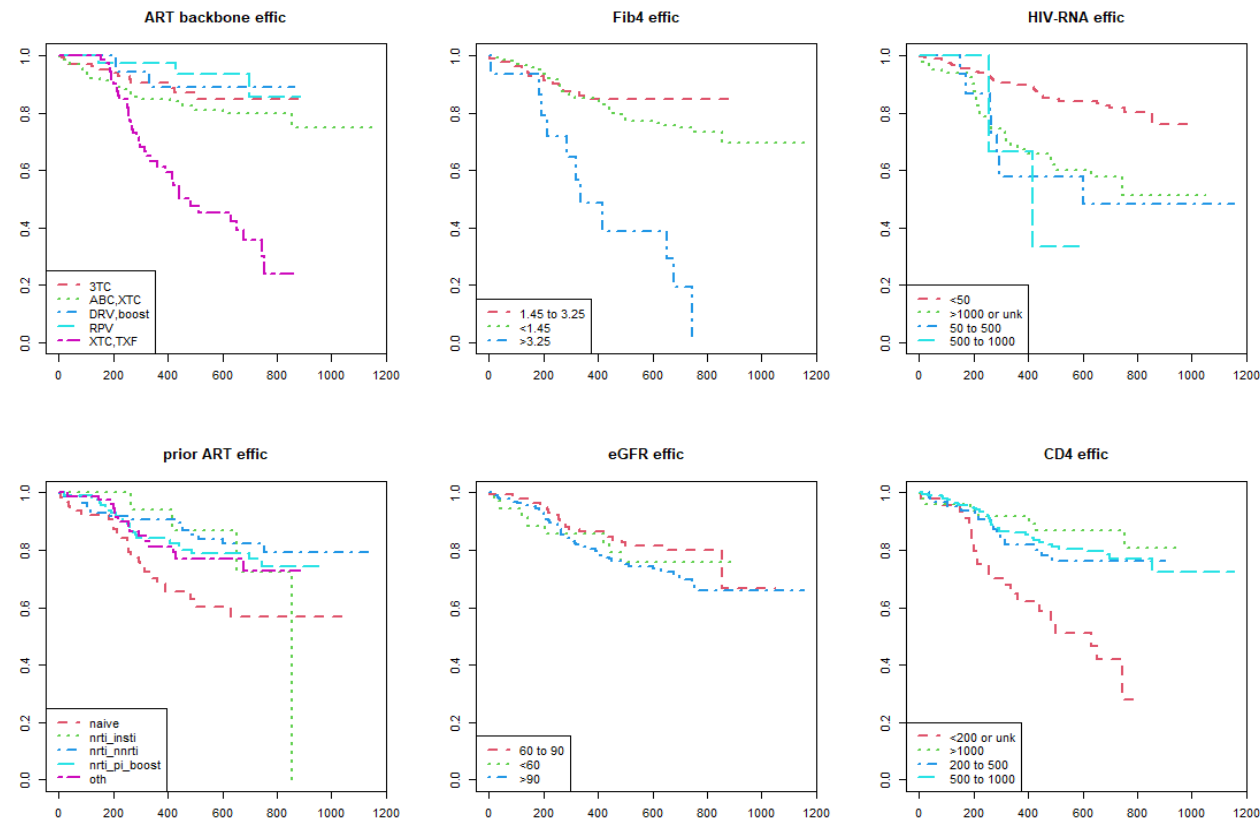
Figure 2. Kaplan–Meier survival curves show the time to an efficacy event of dolutegravir-based antiretroviral therapies among persons with HIV enrolled in the Italian MaSTER cohort. Plots are stratified by: ART backbone, FIB4 score, HIV RNA, previous ART, eGFR, CD4+ T-cell count. EFFIC, efficacy; ART, antiretroviral treatment; NRTI, nucleos(t)ide reverse transcriptase inhibitors; NNRTI, non-nucleos(t)ide reverse transcriptase inhibitors; INSTI, integrase strand inhibitors; PI, protease inhibitors; RPV, rilpivirine; TXF, tenofovir alafenamide or tenofovir disoproxil fumarate; XTC, emtricitabine or lamivudine; 3TC, lamivudine; ABC, abacavir; DRV, darunavir; Boost, ritonavir- boosted regimens; OTH, other; eGFR, estimated Glomerular Filtration Rate. X -axis: time (days); Y - axis: survival rate (%).